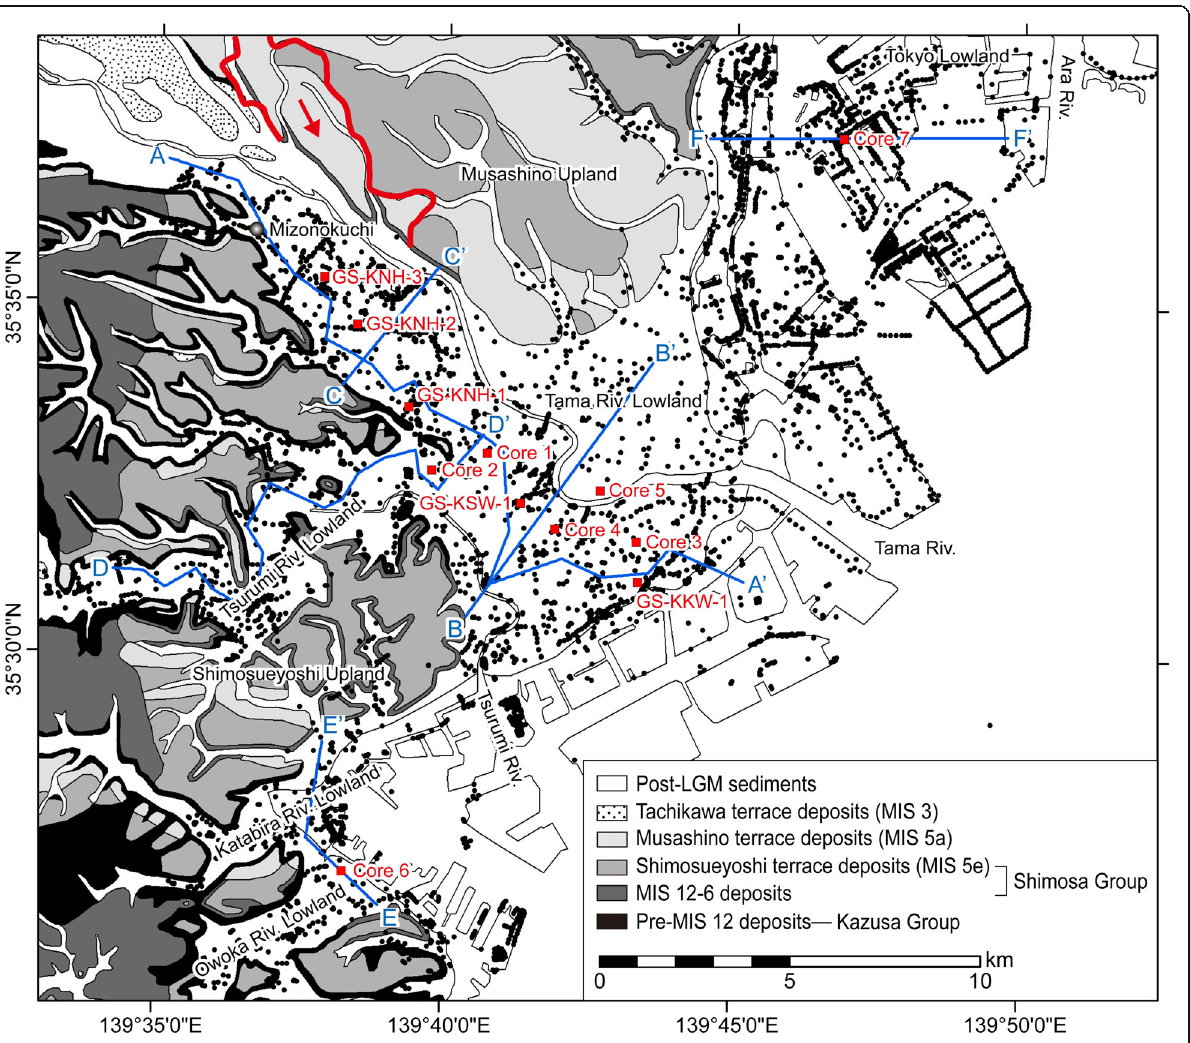
Fig. 2 Geological map of the area in and around the Tama River Lowland. Red squares indicate the locations of stratotype cores used in this study. Black dots indicate the locations of borehole logs used to reconstruct the morphology of the LGM incised valley. The blue lines and letters denote the cross sections shown on Fig. 6. Red lines indicate the position of the MIS 6 incised valley filled with the relatively soft Shimosa Group (Nakazawa et al. 2019). The MIS 6 incised valley flowed down in the direction of the red arrow. The geological map is based on Geological Survey of Japan, AIST